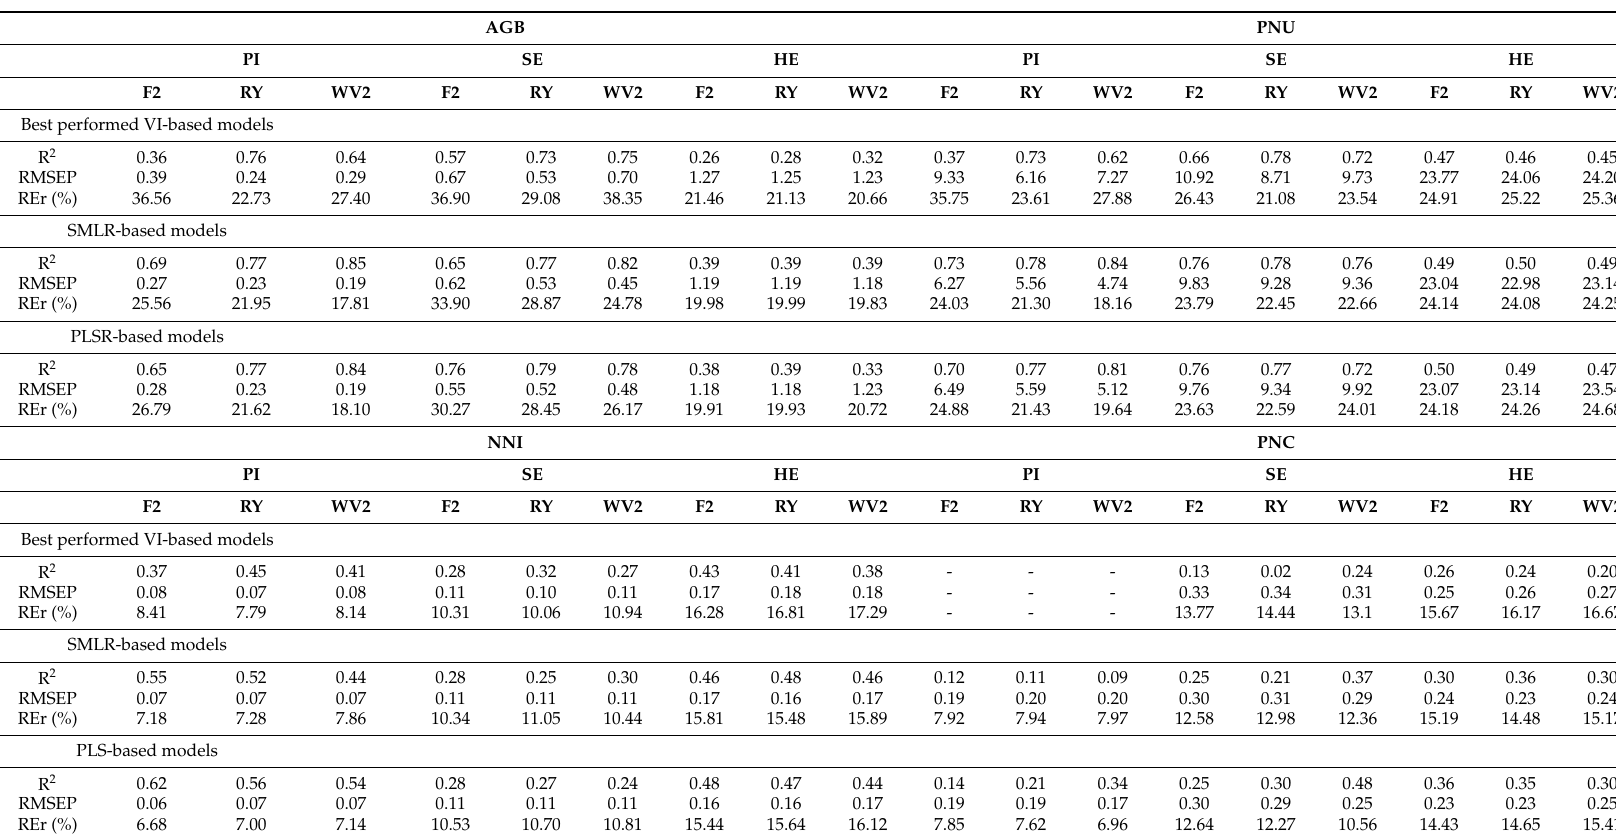
Table 9. Comparison of the validation results for the best performed vegetation indices (VIs), the stepwise multiple linear regression (SMLR) models, and the partial least squares regression (PLSR) models for biomass (AGB), plant N uptake (PNU), nitrogen nutrition index (NNI), and plant N concentration (PNC) estimations at the panicle initiation (PI), stem elongation (SE) and heading (HE) stages. RMSEP stands for the RMSE of validation